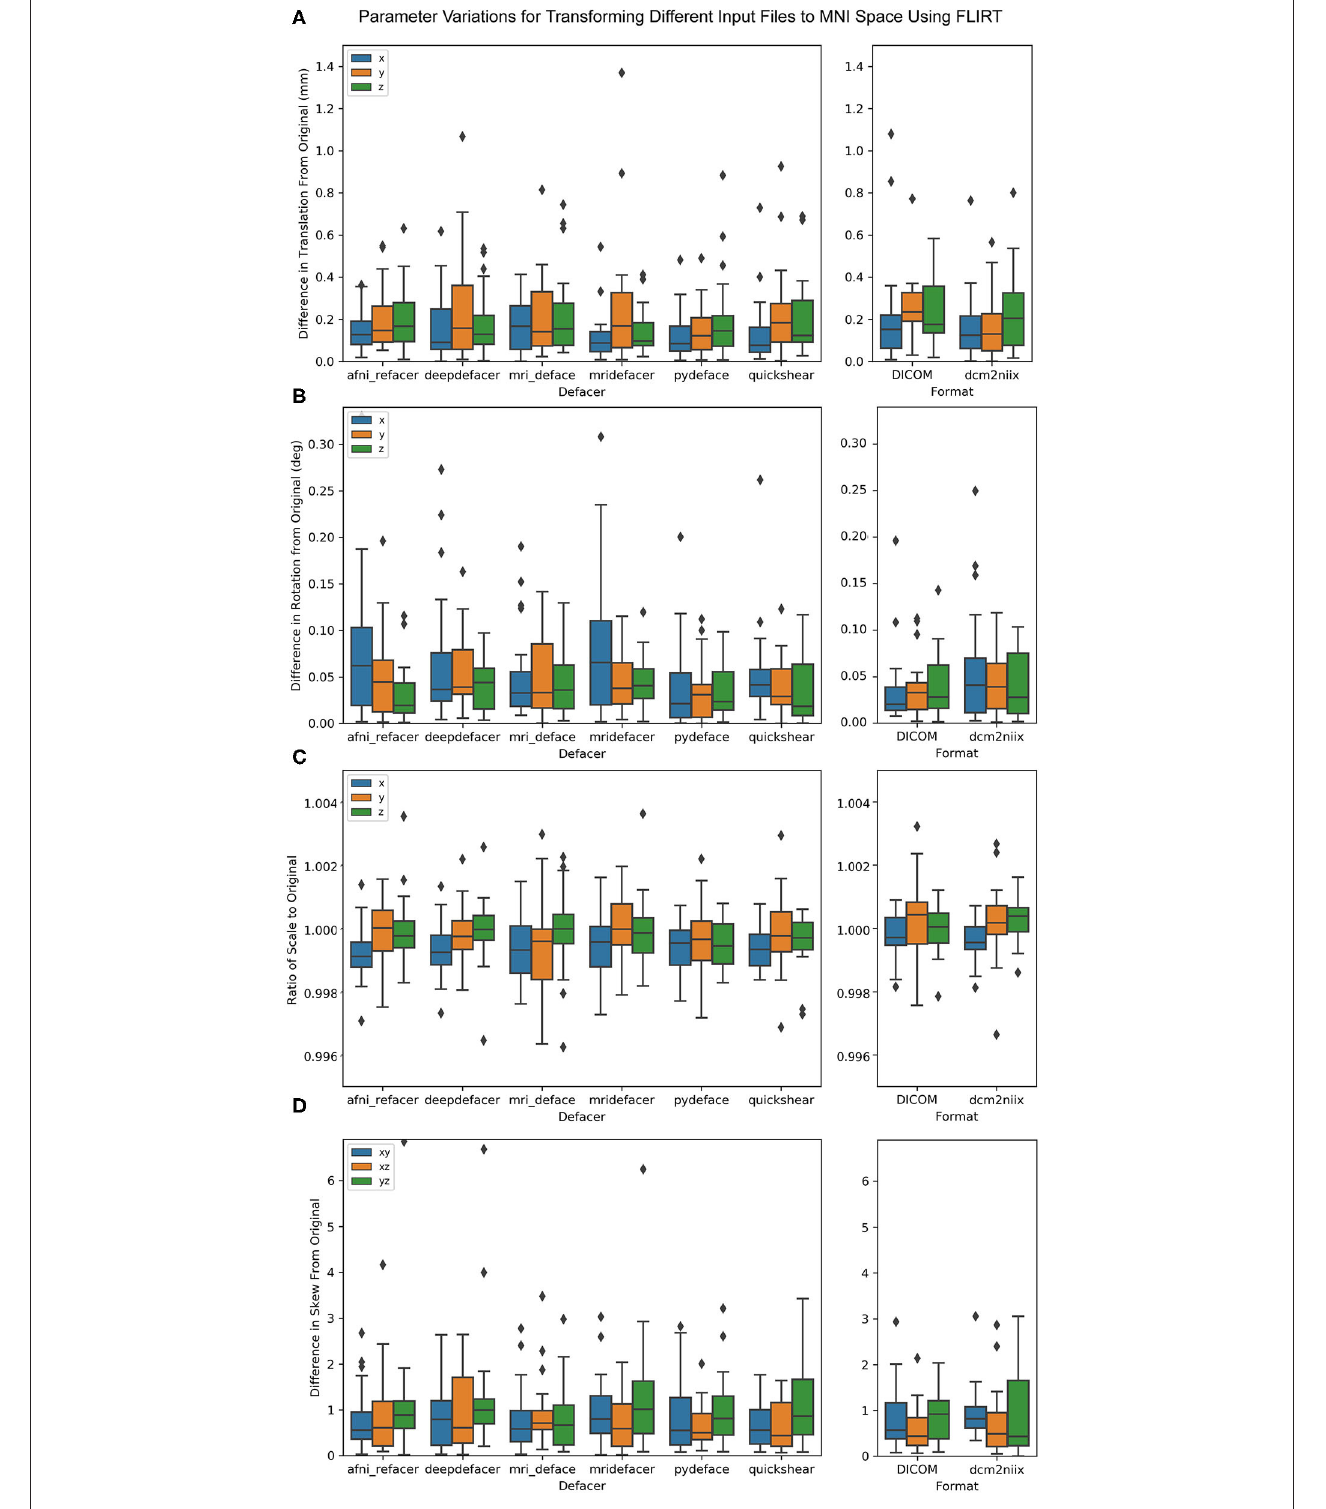
FIGURE 9 | Boxplot of the difference between FLIRT parameters for the original scans and the defaced scans (left) and different file formats (right) when aligned to the MNI 152 brain template. Parameters have been split by translation in mm (A) , rotation converted to degrees (B) , scale (C) , and skew (D) .